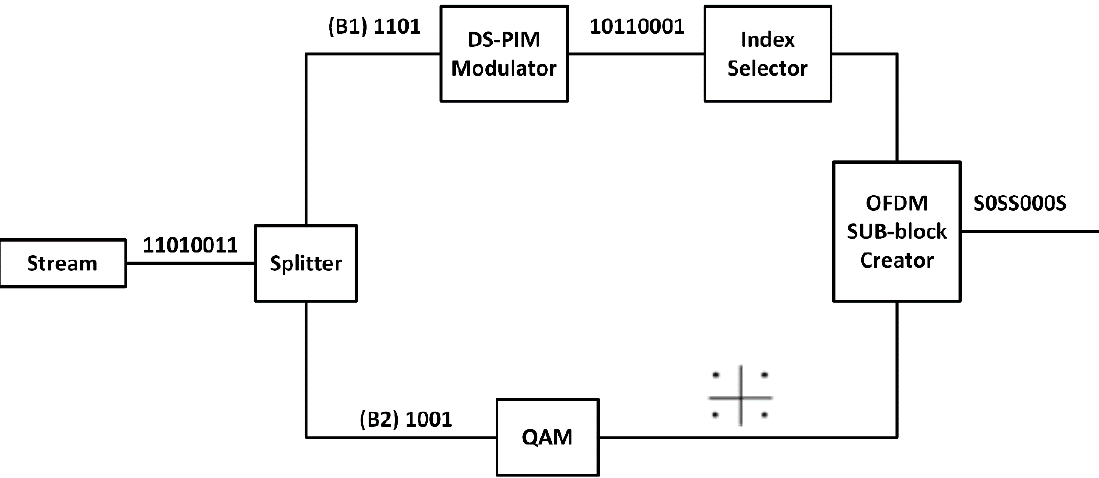
Figure 5. Block diagram of SIM OFDM sub-block creator, using the proposed technique.